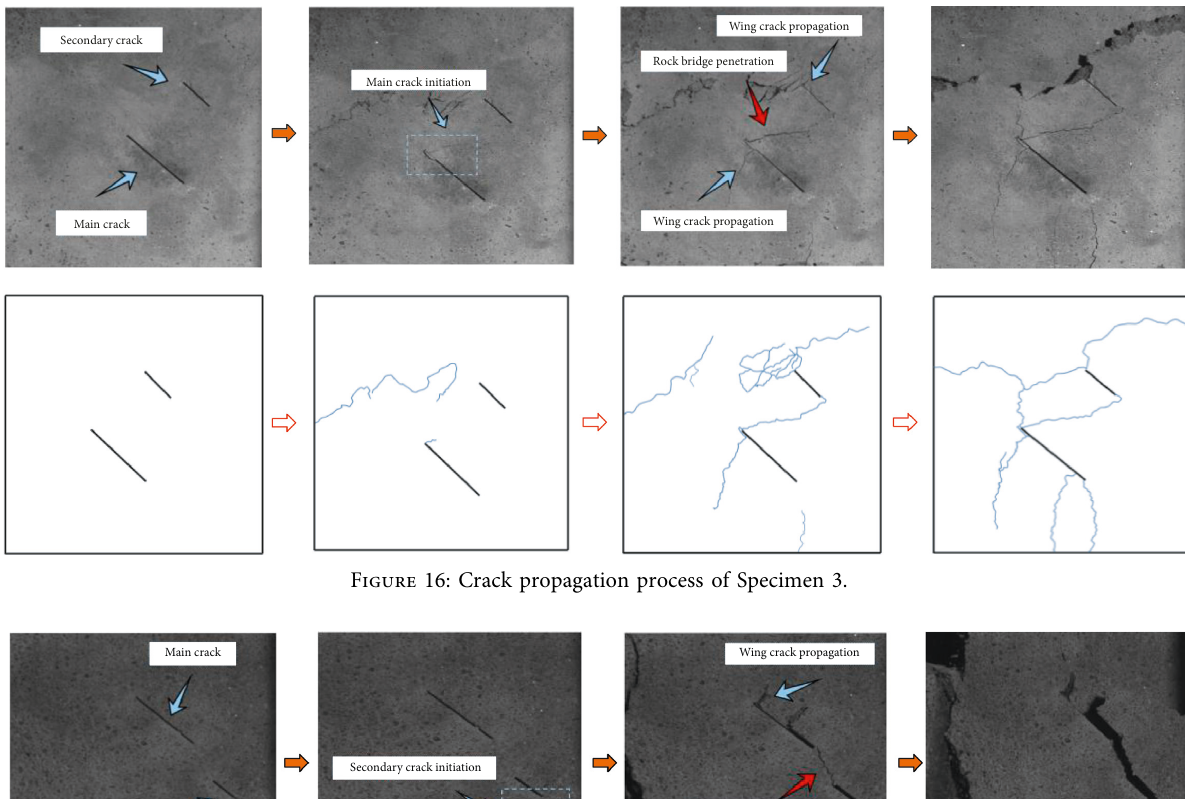
Figure 16: Crack propagation process of Specimen 3.